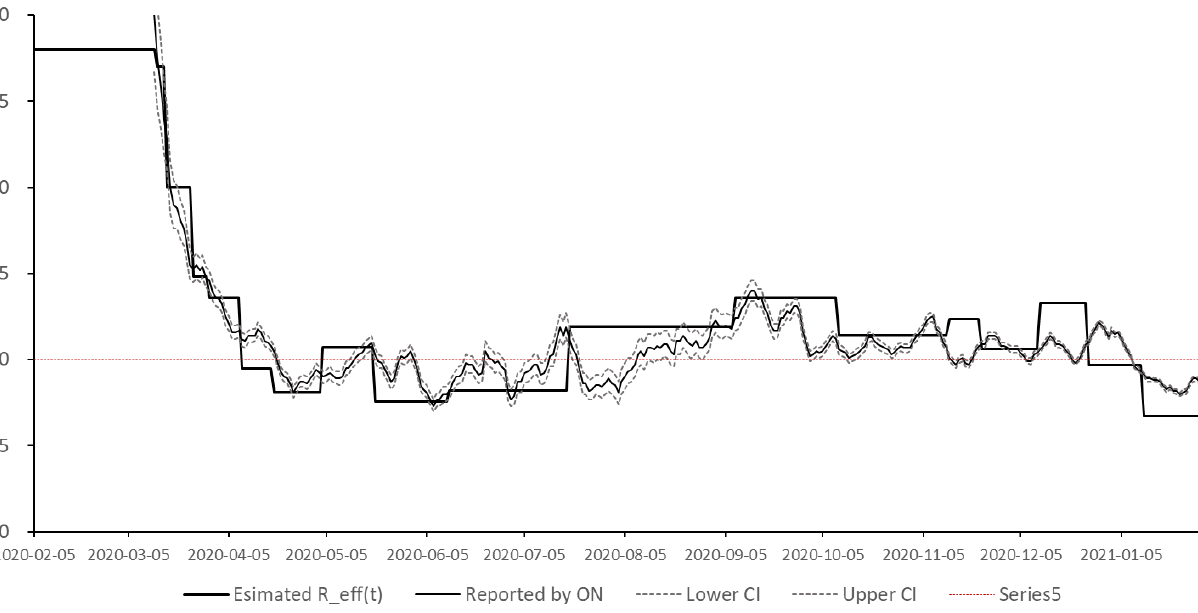
Figure A3.4: Comparison of the effective reproductive number estimated by the COVID-19 Healthcare Capacity Planning Tool versus those published by the Government of